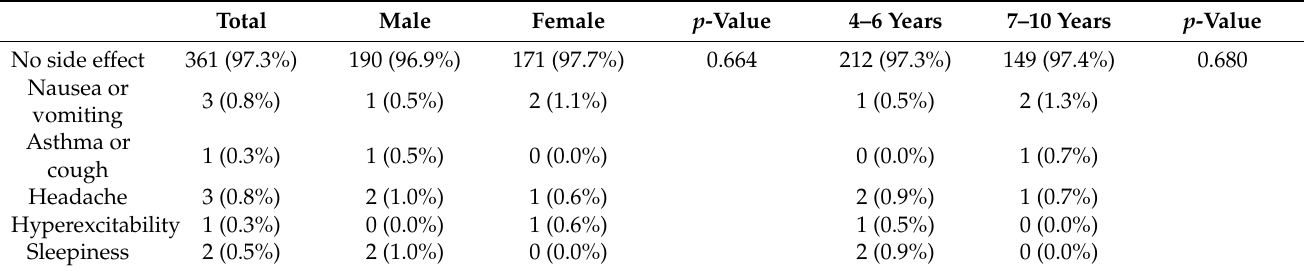
Table 5. Side effects within 48 h after dental